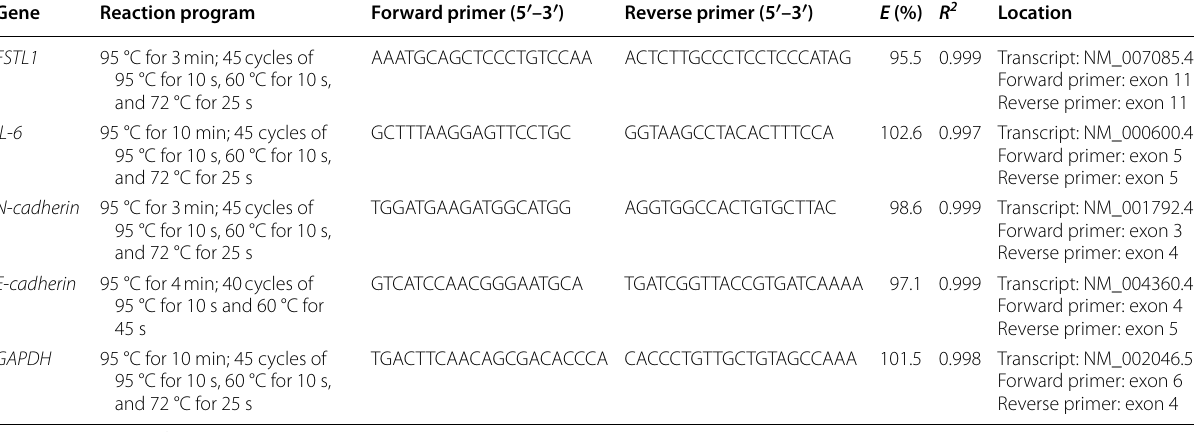
Table 1 Primers and reaction conditions for the measurement of gene transcriptional levels using quantitative reverse transcription-polymerase chain